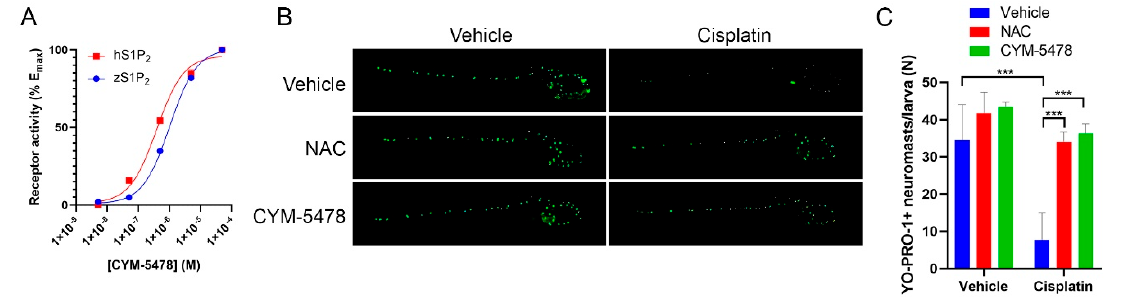
Figure 3. CYM-5478 attenuates cisplatin-mediated degeneration of zebrafish hair cells. ( A ) CYM-5478-mediated activation of the zebrafish homolog of S1P 2 (zS1P 2 ) was evaluated by the receptor-specific TGF α -shedding assay. Human S1P 2 (hS1P 2 ) was used as a reference. ( B ) Representative images of zebrafish larvae treated with cisplatin in the presence of NAC (1 mM) or CYM-5478 (20 µ M). Viable neuromasts were labeled with YO-PRO-1. ( C ) Quantification of YO-PRO-1-positive neuromasts. (*** p < 0.001, n = 4).